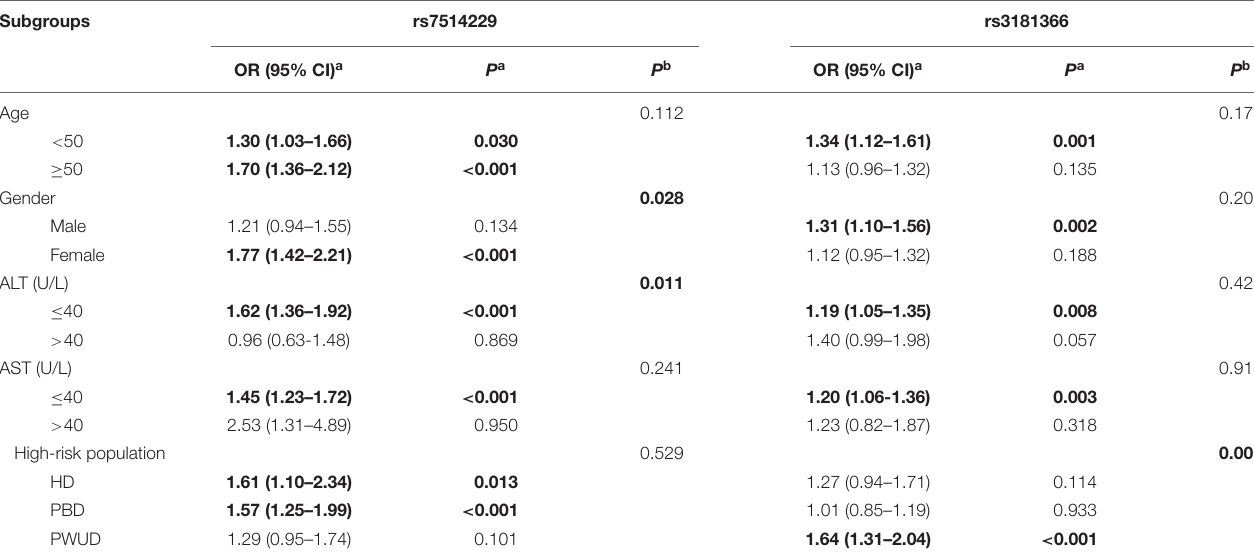
TABLE 4 | Stratified analysis of rs7514229 and rs3181366 between HCV-infected and uninfected control